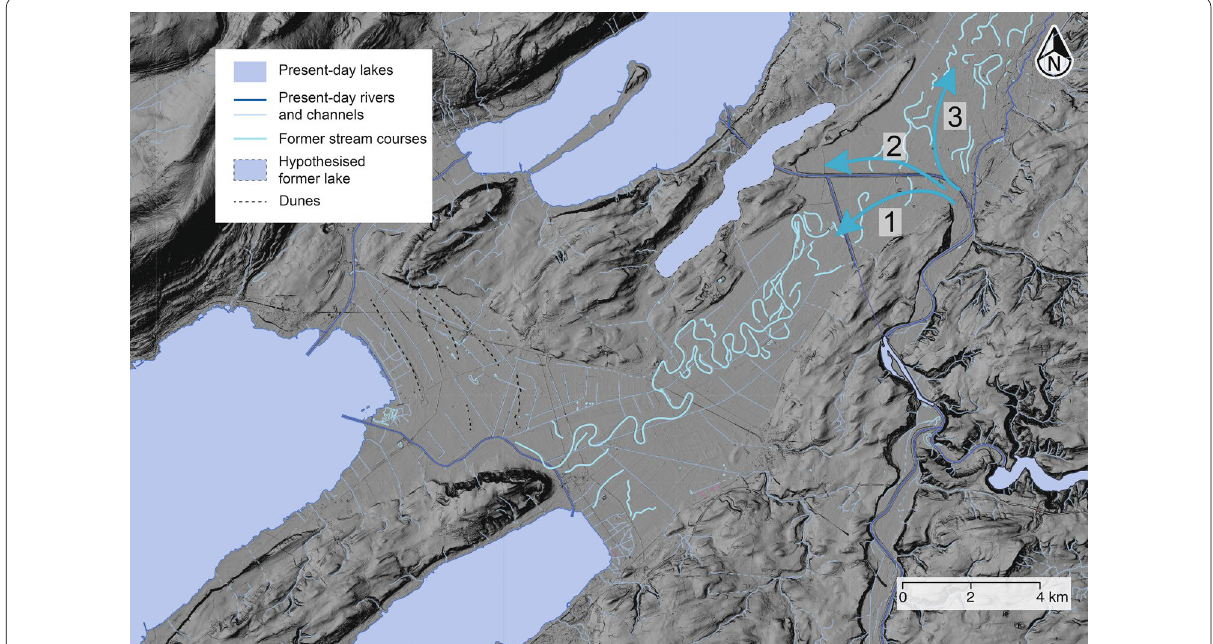
Fig. 11 Former stream courses of the Aare river in direction to the lake of Neuchâtel (1) until about 5 ka BP (Wohlfarth-Meyer 1987), (2) hydrological connection of the Aare river with the former lake in western part of the main plain (Grosses Moos) until about 13 ka BP and (3) main drain of the Aare river for about the last 3–5 kyr. Note also the former extension of the lake of Neuchâtel (dunes) ( Source: SwissALTI3D